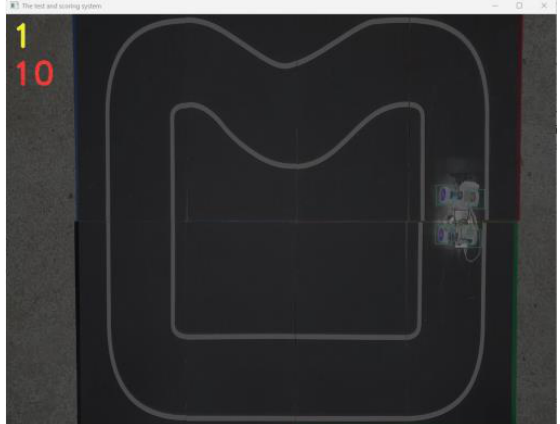
Figure 12. Screenshot of the execution of the test and scoring system.